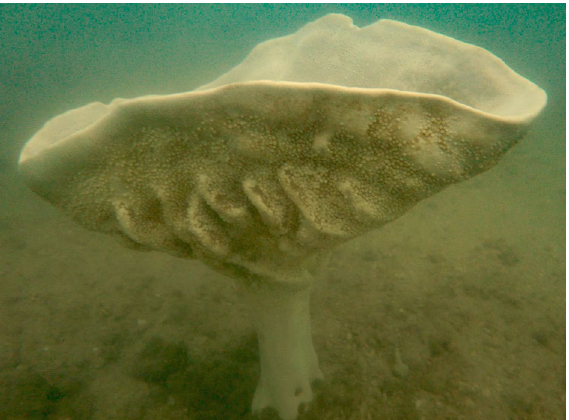
Figure 1. A live specimen of Cliona patera in Singapore, photographed in November